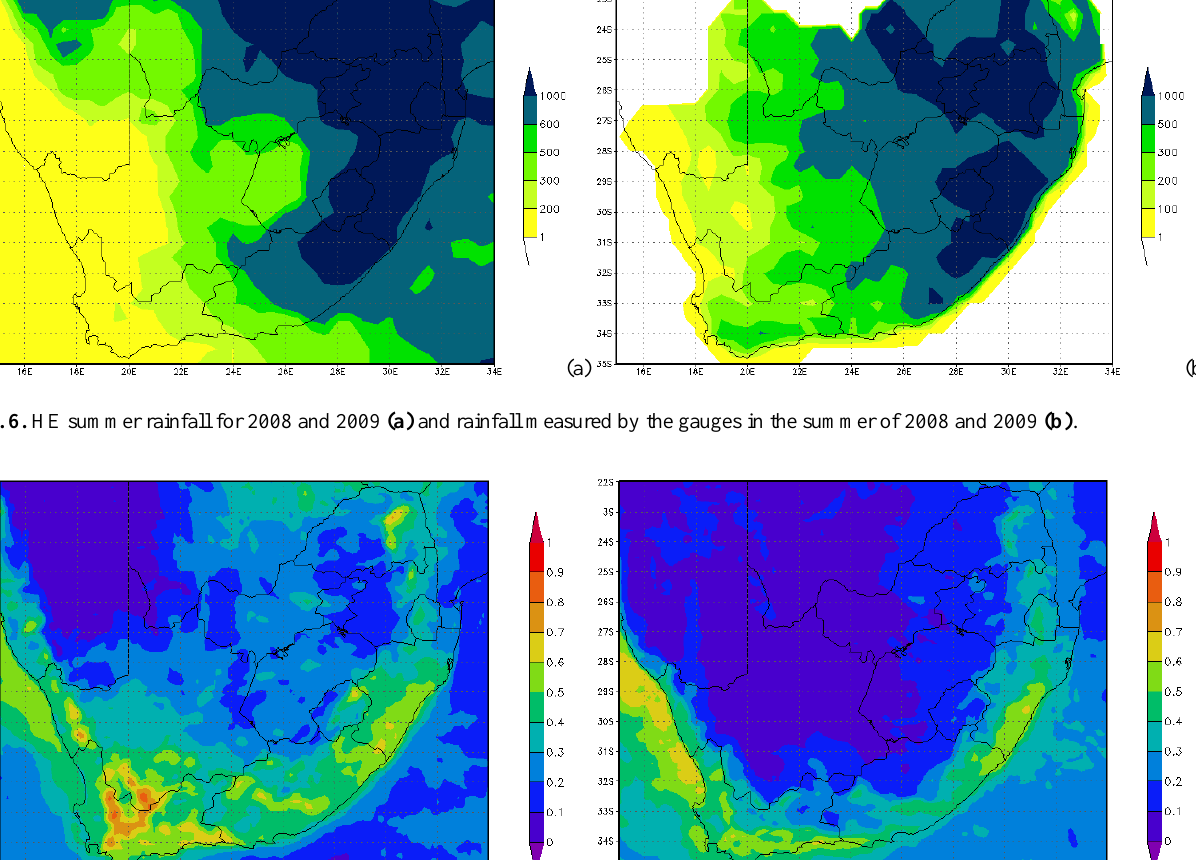
with an East/West resolution of 0.11 ◦ and a North/South res- olution of 0.1112 ◦